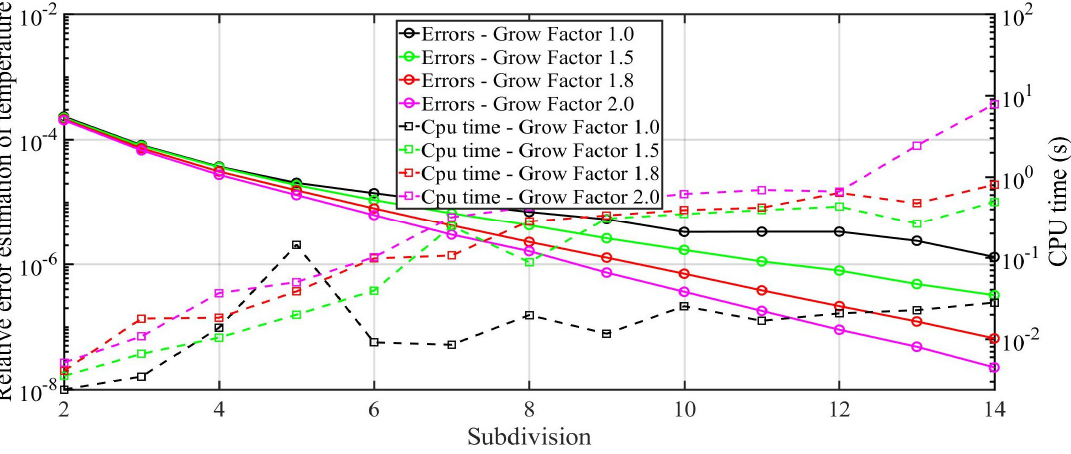
Figure 15. Relative maximum temperature error estimations of the outer surface (Case 2).